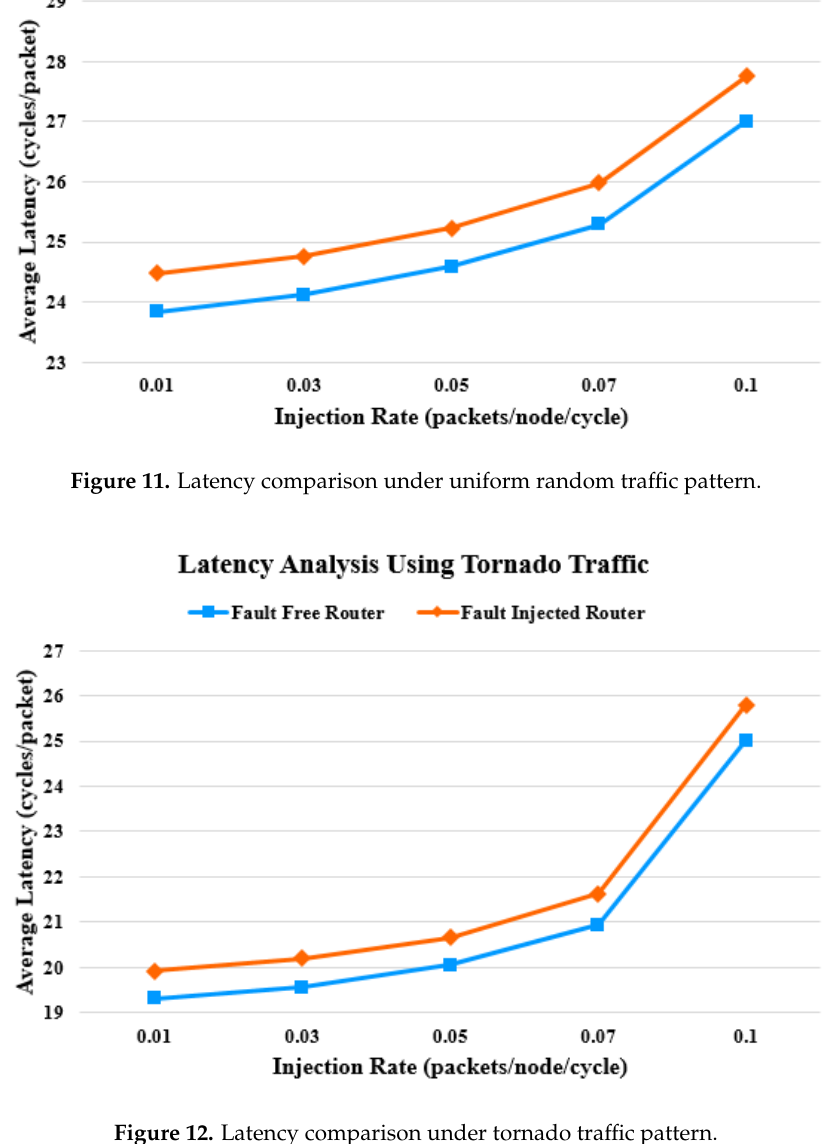
Figure 12. Latency comparison under tornado traffic